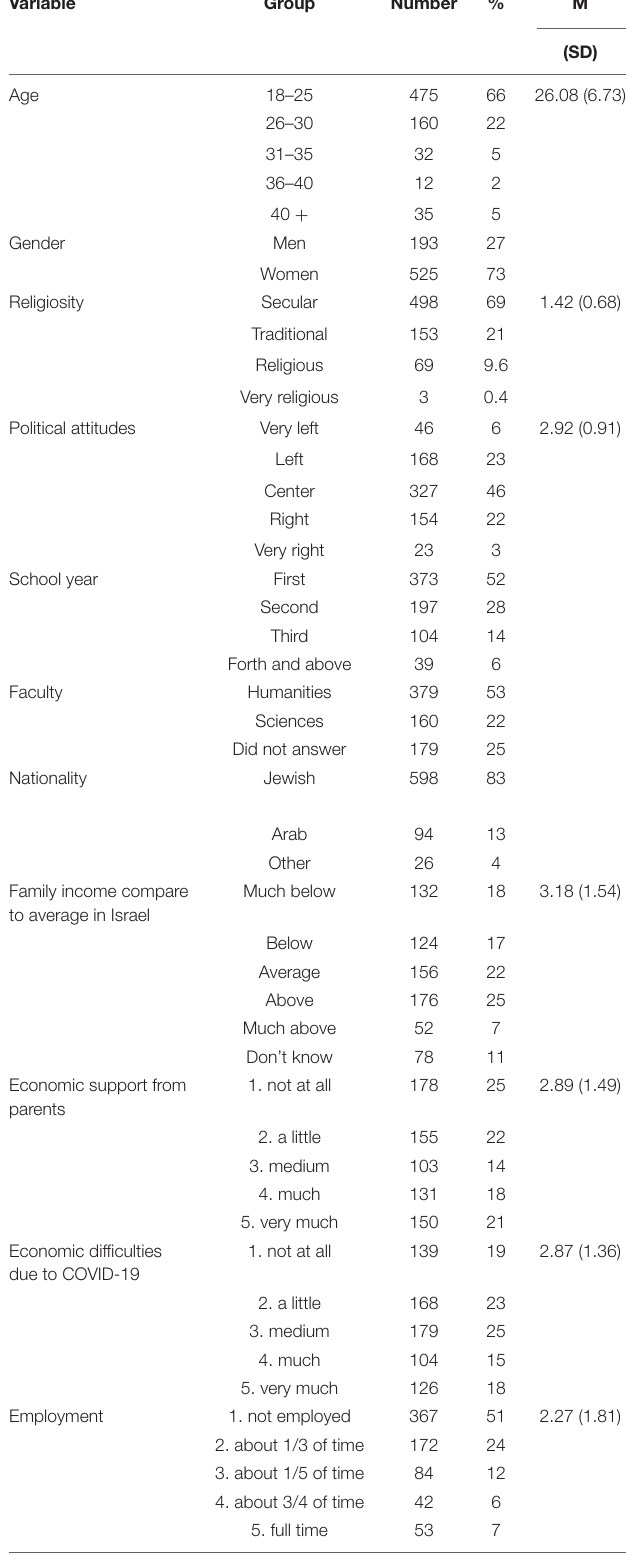
TABLE 1 | Distribution of the characteristics of the participants ( N =